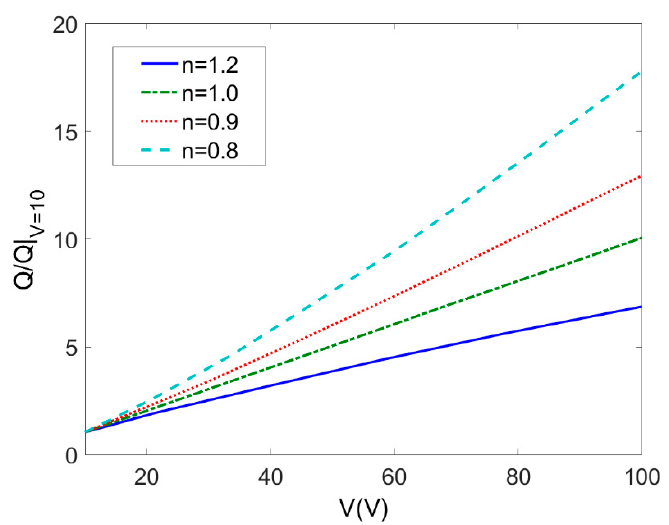
Figure 7. Variation of the total flow rates generalized by the total flow rate when V = 10 V with applied voltage at different flow behavior indices n ( c = 0.01 mol/m 3 , ζ = − 0.1 V, L = 20 μ m, φ = 0.05).